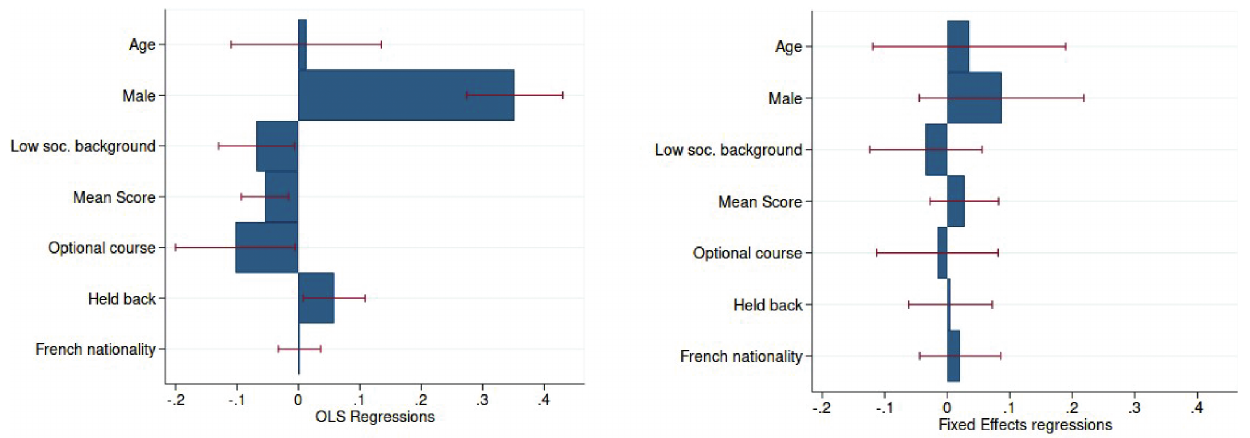
Balancing tests for the proportion of peers with C feedback.